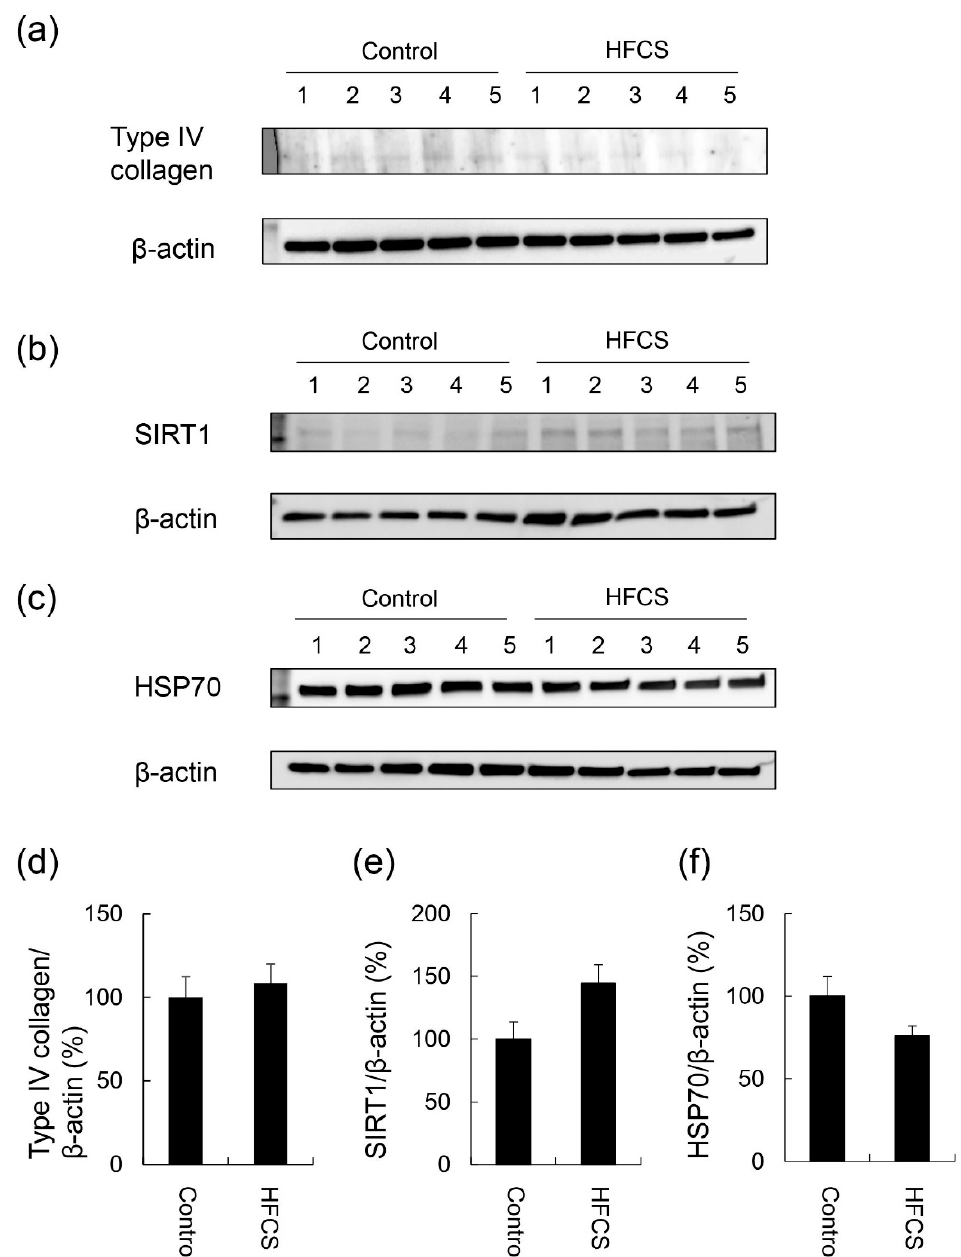
Figure 4. Expression of type IV collagen, SIRT1, and HSP70 in the liver. Control; control group ( n = 5), HFCS; HFCS group ( n = 5). The numbers 1–5 indicate each rat in the control or HFCS group. Tissue lysates (15 µ g of protein / lane) were loaded on 4–15% gradient polyacrylamide gels. Proteins on polyvinylidene difluoride (PVDF) membranes were probed with anti-type IV collagen, anti-SIRT1, anti-HSP70, and anti- β -actin antibodies. ( a ) Type IV collagen and β -actin bands were analyzed with Western blotting (WB). ( b ) SIRT1 and β -actin bands were analyzed with WB. ( c ) HSP70 and β -actin bands were analyzed with WB. ( d ) The expression of type IV collagen in the control and HFCS groups was normalized with β -actin. ( e ) The expression of SIRT1 in the control and HFCS groups was normalized with β -actin. ( f ) The expression of HSP70 in the control and HFCS groups was normalized with β -actin. ( a – c ) β -actin was used as the loading control. ( d – f ) Data are shown as means ± S.E. ( n = 5). p -Values were based on the Mann-Whitney U-test.